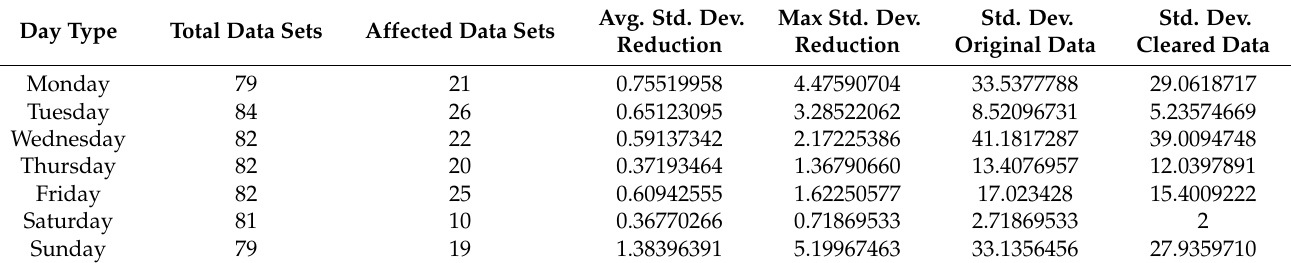
Table 17. Semester II baseline for original and cleared data sets.